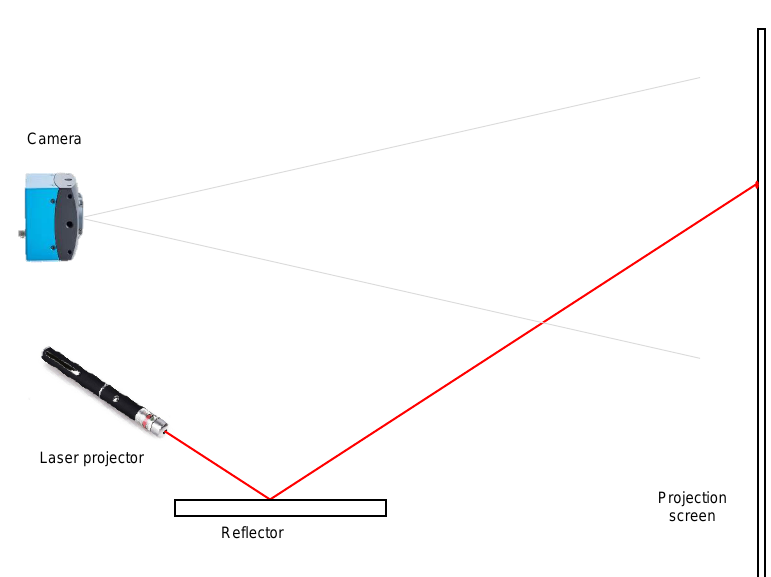
Figure 5. Measurement of influence of the pollutants in the visible spectrum.